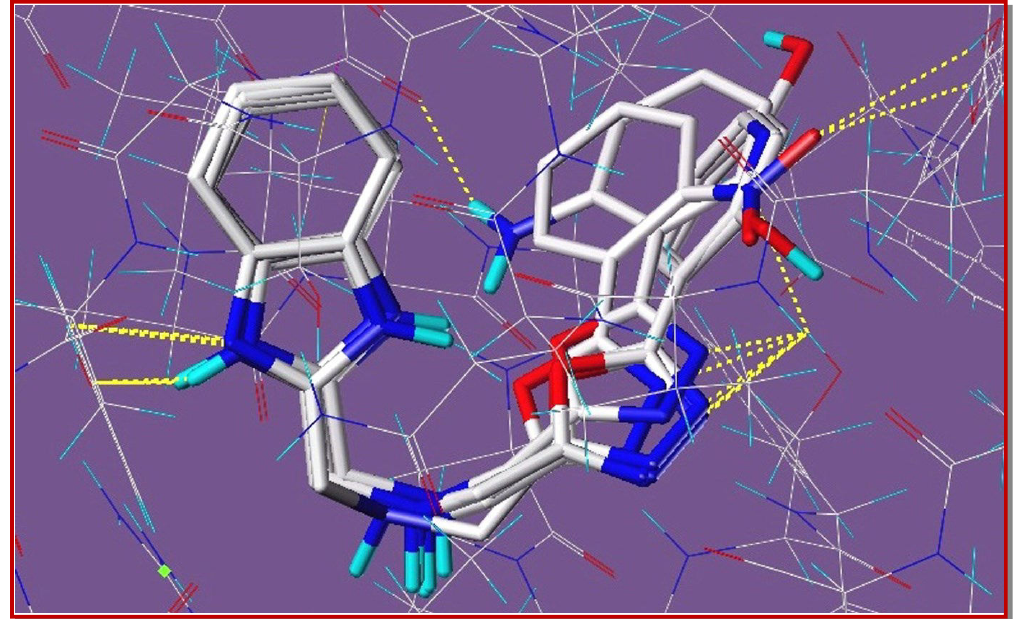
Figure 3: Energy minimized and conformationally analyzed structures aligned against common atoms interacting with protomol 1NFY